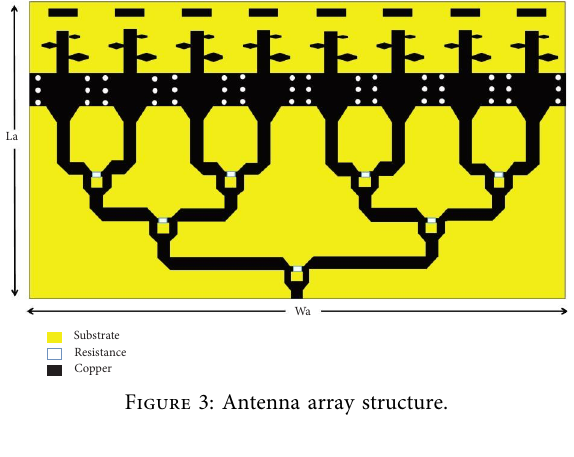
Figure 3: Antenna array